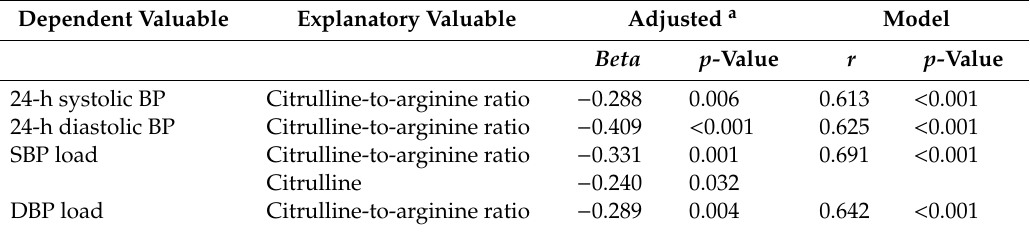
Table 5. Adjusted regression model estimates (betas, p -values) of the association between BP load and NO-related biomarkers in children with